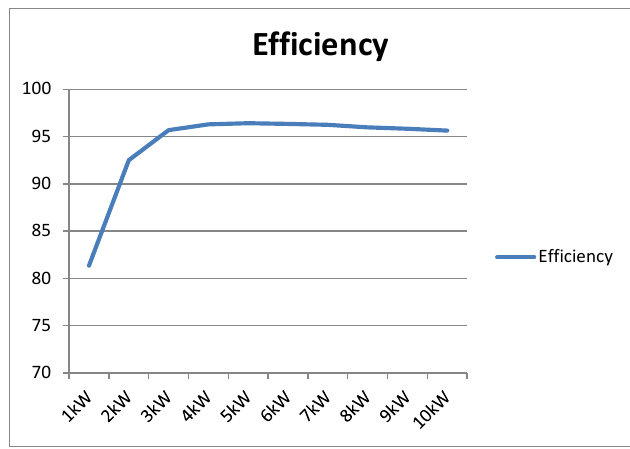
Figure 21. Efficiency according to the load area measured